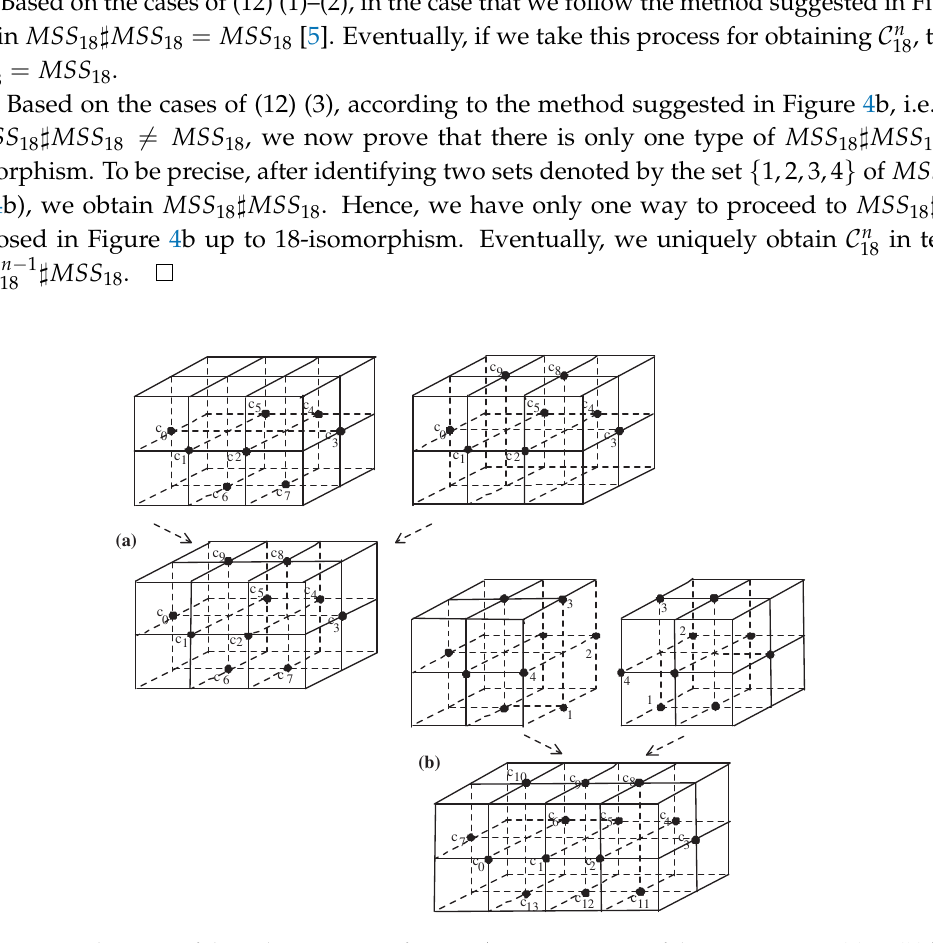
Figure 4. Explanation of the only two types of MSS 18 (cid:93) MSS 18 in terms of the processes via ( a ) or ( b )